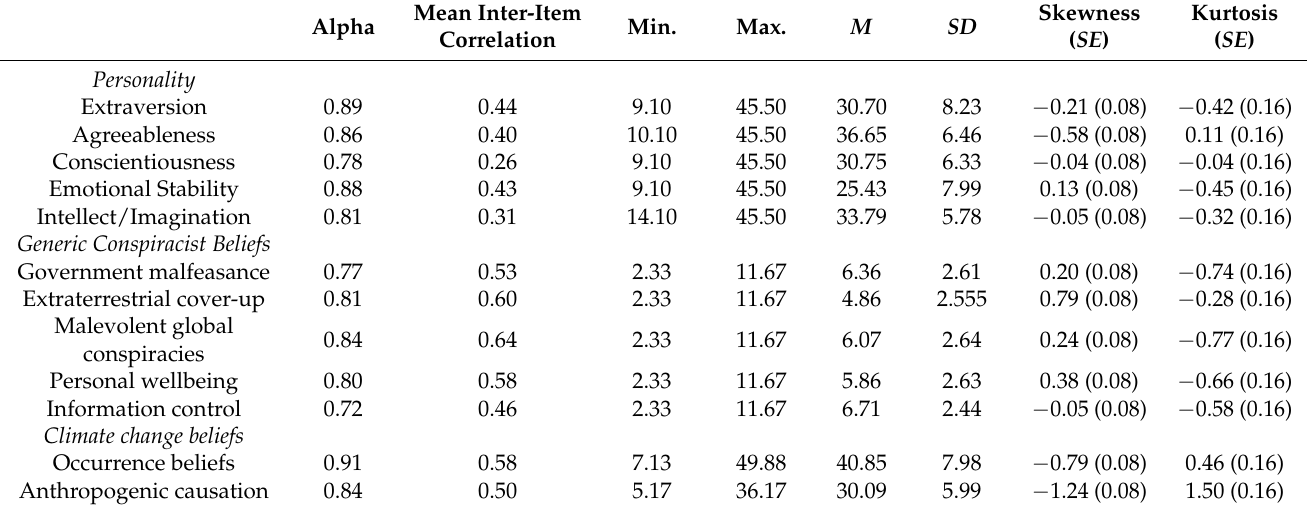
Table 1. Descriptive statistics of the main study